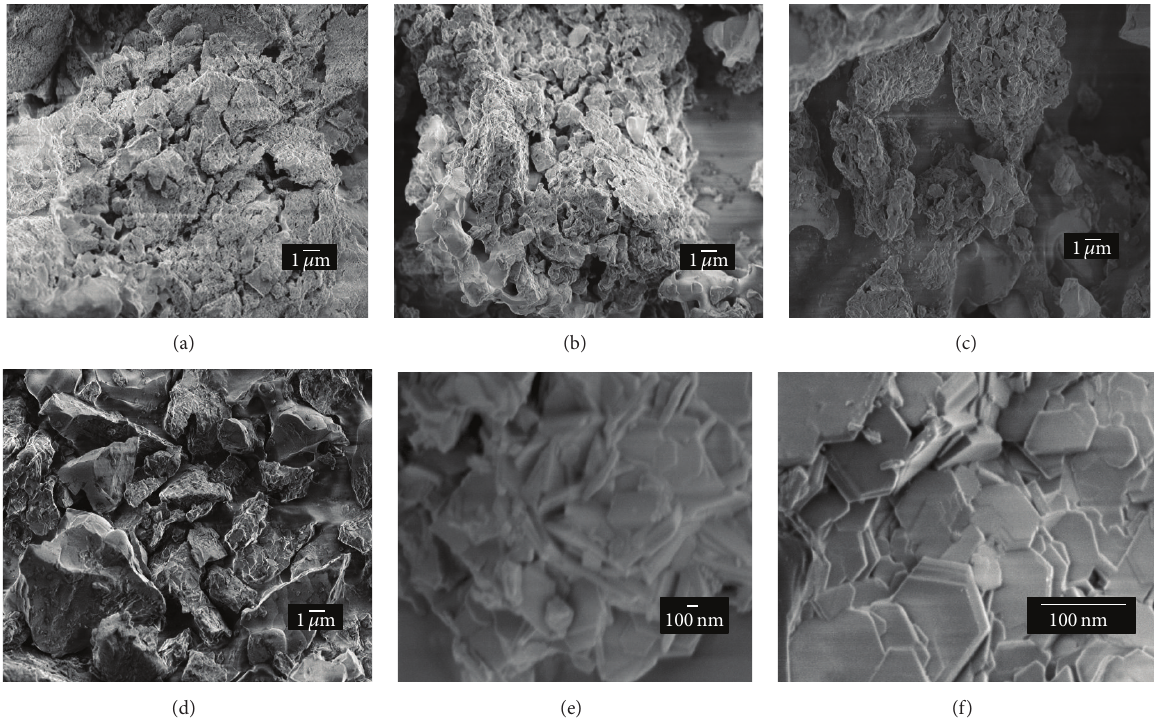
Figure 2: SEM images of samples annealed at (a) 1000 ∘ C, (b) 1150 ∘ C, (c) 1200 ∘ C, and (d) 1300 ∘ C. (e) and (f) are a zoom of the samples annealed at 1150 ∘ C and 1300 ∘ C, respectively.